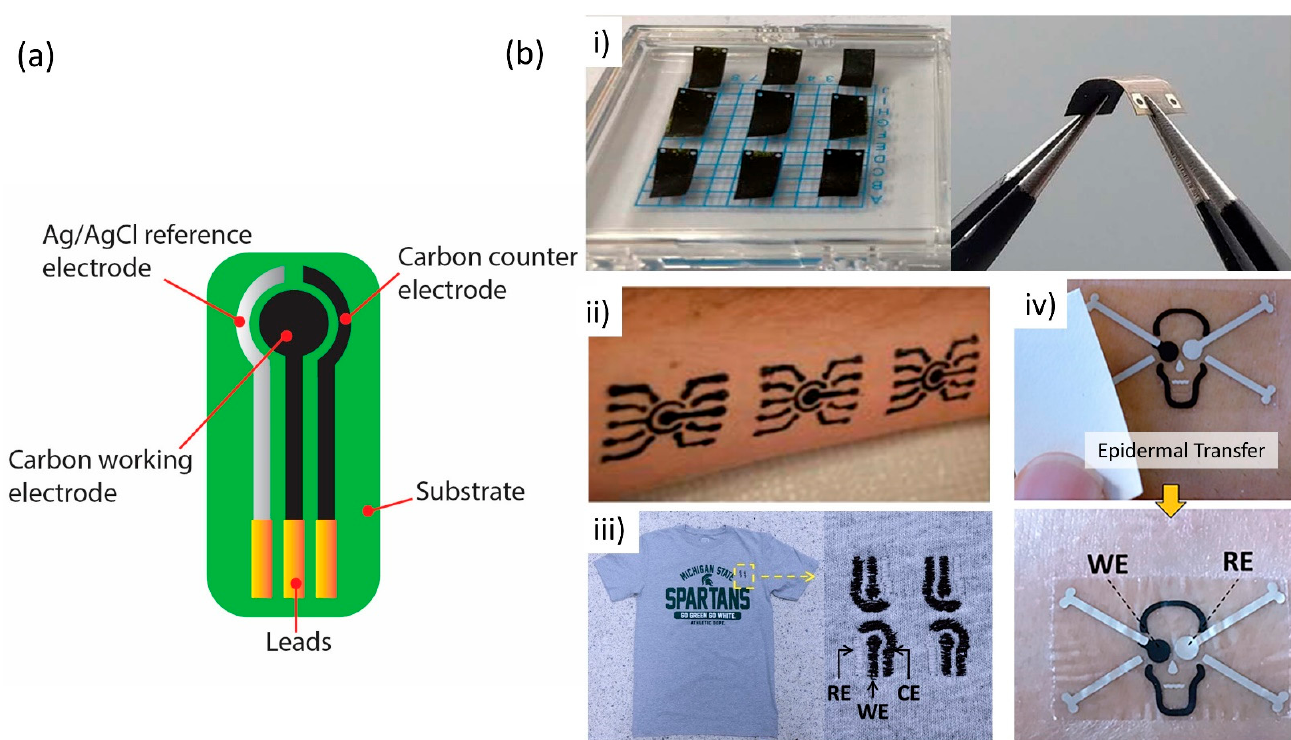
Figure 2. ( a ) A scheme of construction for a printed electrochemical sensor. The printed electrochemical sensors consist of three electrode systems, the working electrode, the counter electrode, and the reference electrode. ( b ) Printed sensor electrodes on various types of substrates, ( b-i ) printed electrochemical pH sensor on a flexible thin film. Reproduced/Adapted from Ref. [55] with permission from The Royal Society of Chemistry, ( b-ii ) sensor arrays printed on the skin epidermis. Reproduced/Adapted from Ref. [56] with permission from The Royal Society of Chemistry, ( b-iii ) printed sensors on textile and its zoomed-in image. Reproduced/Adapted from Ref. [57] with permission from The Royal Society of Chemistry, and ( b-iv ) printed chemical sensor on tattoo transfer paper. Reprinted with permission from [58]. Copyright 2018 Elsevier.